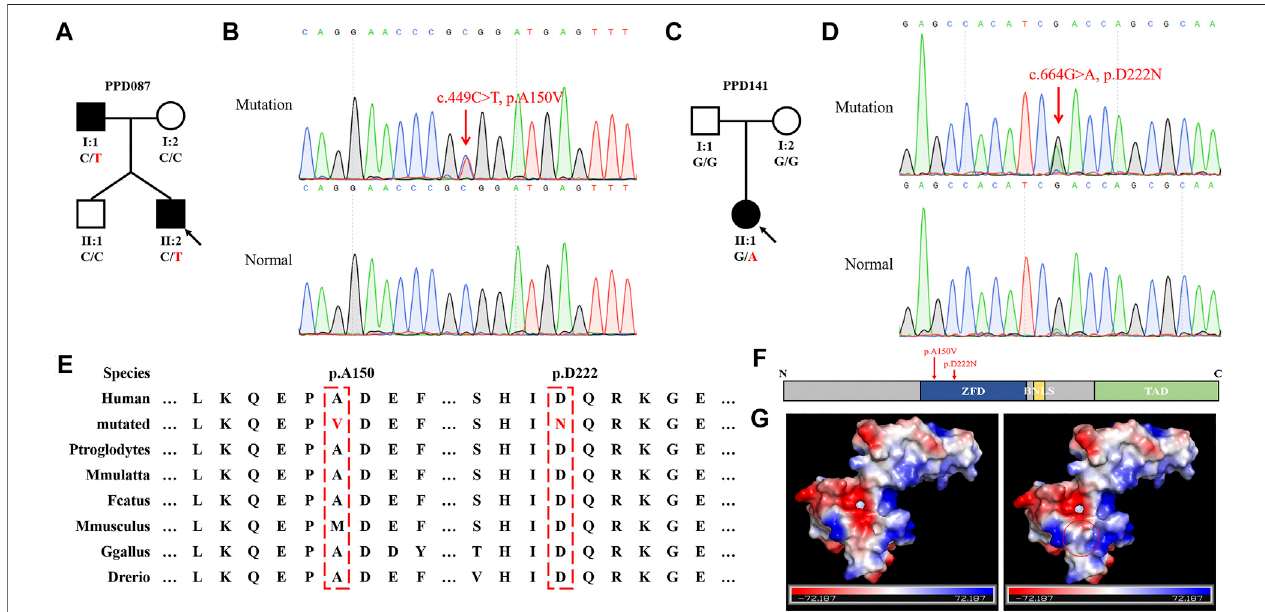
FIGURE3| GLIS1 variantsidenti fi edinPPDIcases. (A,C) PedigreesofPPDIfamilies.Theblacksymbolsrepresentaffectedmembers,andthearrowindicatesthe proband. Genotypes are identi fi ed by letters and a slash, with red representing variants. (B, D) Sanger sequencing results of GLIS1 variants. (E) Species conservation